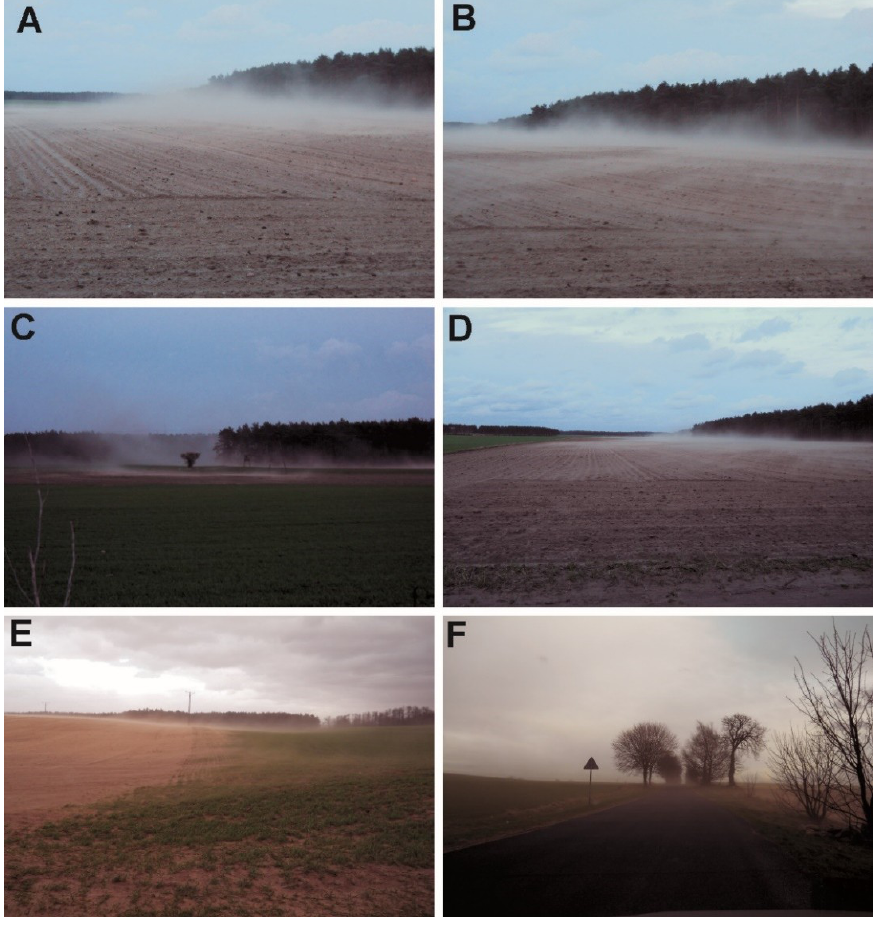
Figure 4. Examples of aeolian transport in the research areas: A – D —Szamocin Field, E —Szamoty 2 Field, F —Swoboda Field (photos taken on 9 April 2011).